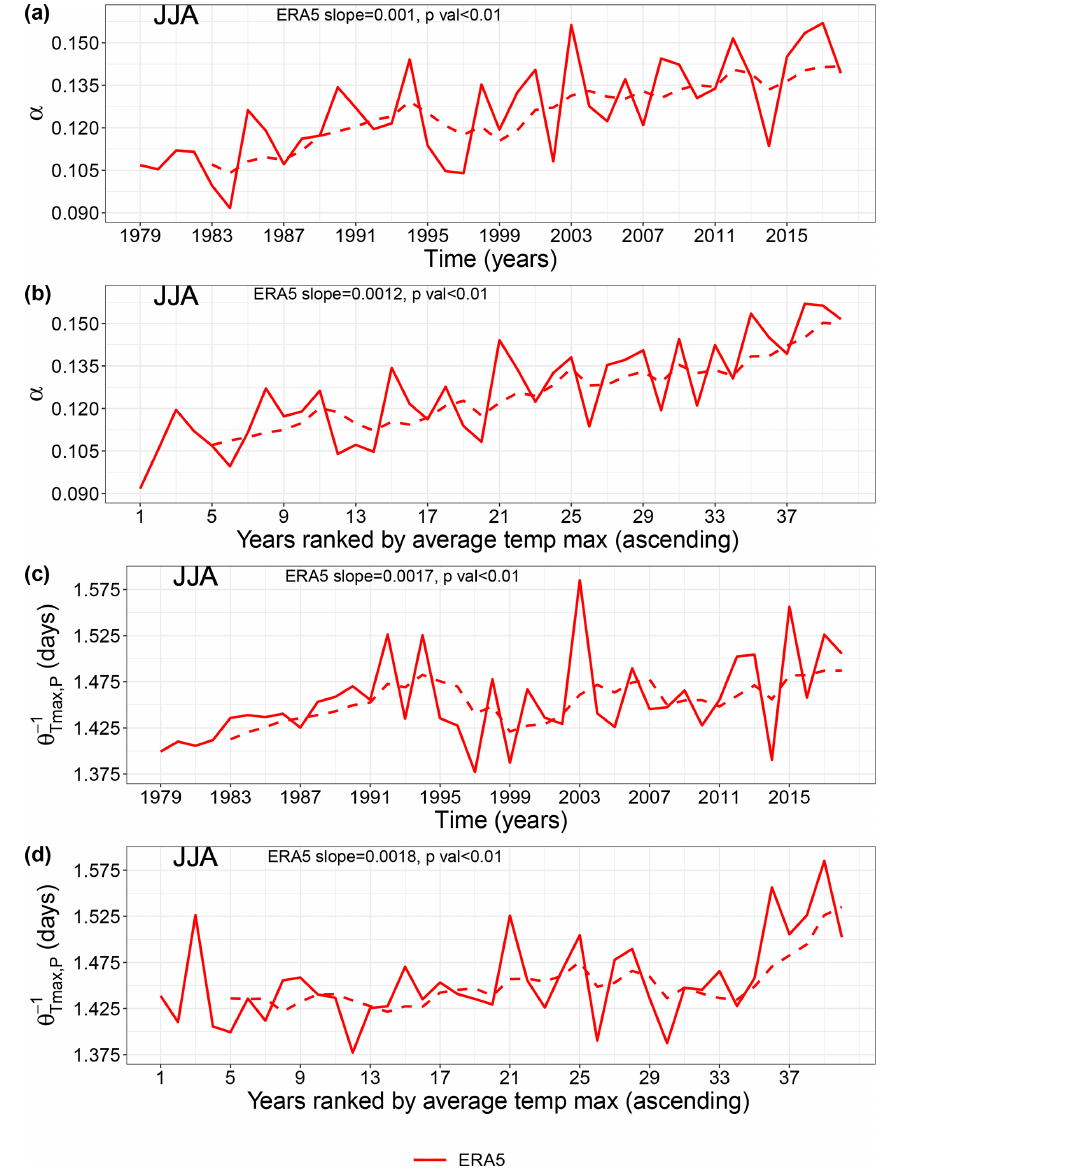
− 1 JJA means for ERA5 during the 1979–2018 period over the Mediter- T max , P JJA yearly means; and (d) θ − 1 T max , P T max , P